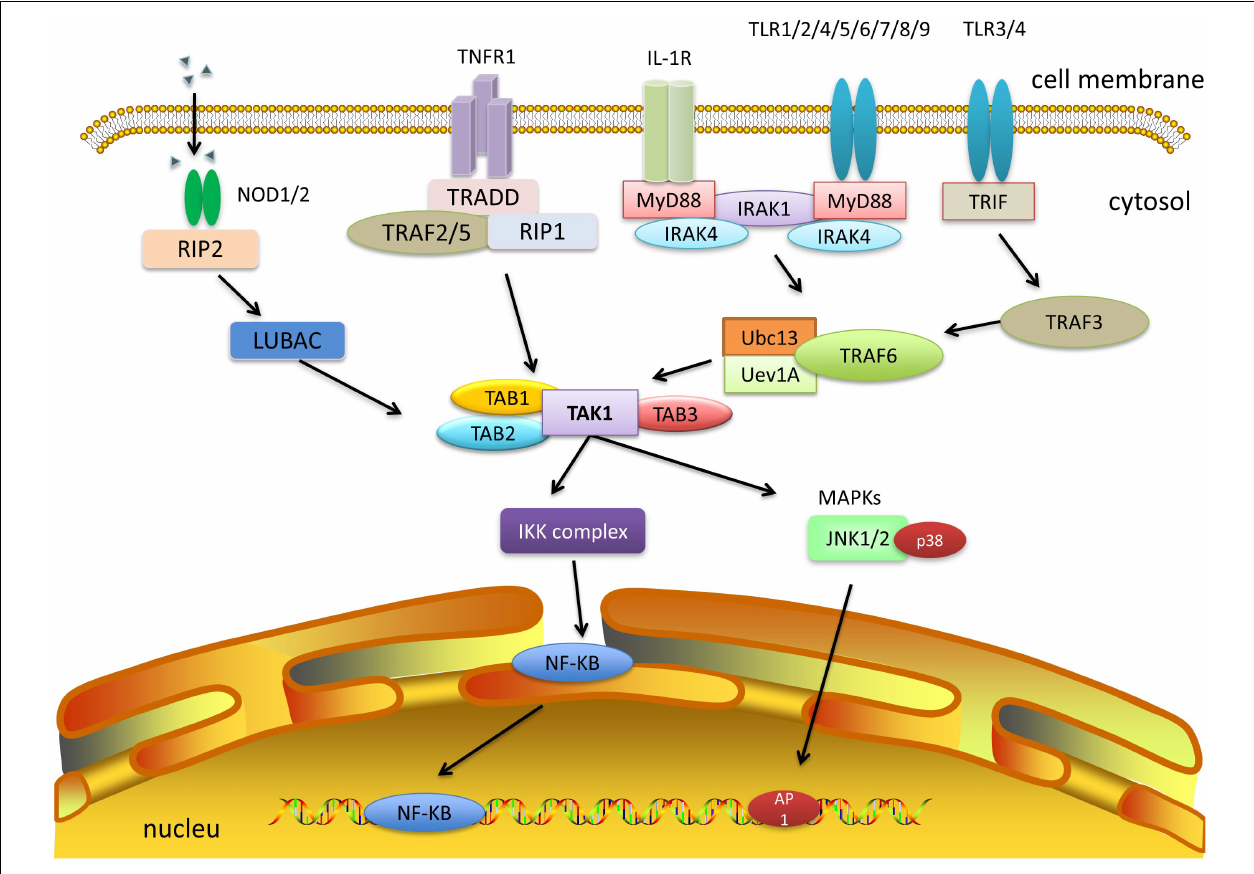
FIGURE 6 | TAK1 and other signaling pathways. IL-1, TNF- α , TLR, and NLR signaling pathways can activate TAK1 and downstream cascades. Among them, both IL-1 and TLR signaling pathways need to activate TRAF6, which combines with Ubc13/Uev1a, and then activates TAK1. TNF- α signaling recruits TRAF2 or TRAF5 and promotes the polyubiquitination of RIP1 to facilitate the activation of TAK1. NLR signaling recruits TAK1 and TABs via autophosphorylation of RIPK2 and its interaction with LUBAC. The formation of a complex of TAK1 and TABs will eventually trigger either the NF- κ B or MAPK